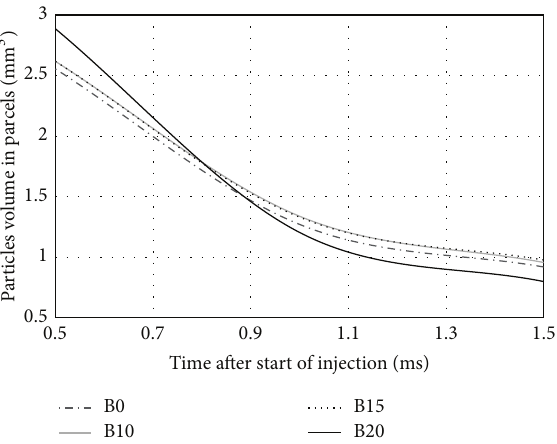
Figure 15: Particles volume in parcels at different HFO/n-butanol blends at injection pressure of 600 bar.